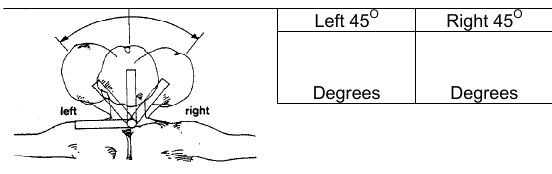
Figure 3. Body joints and vectors as detected by the Kinect sensor.